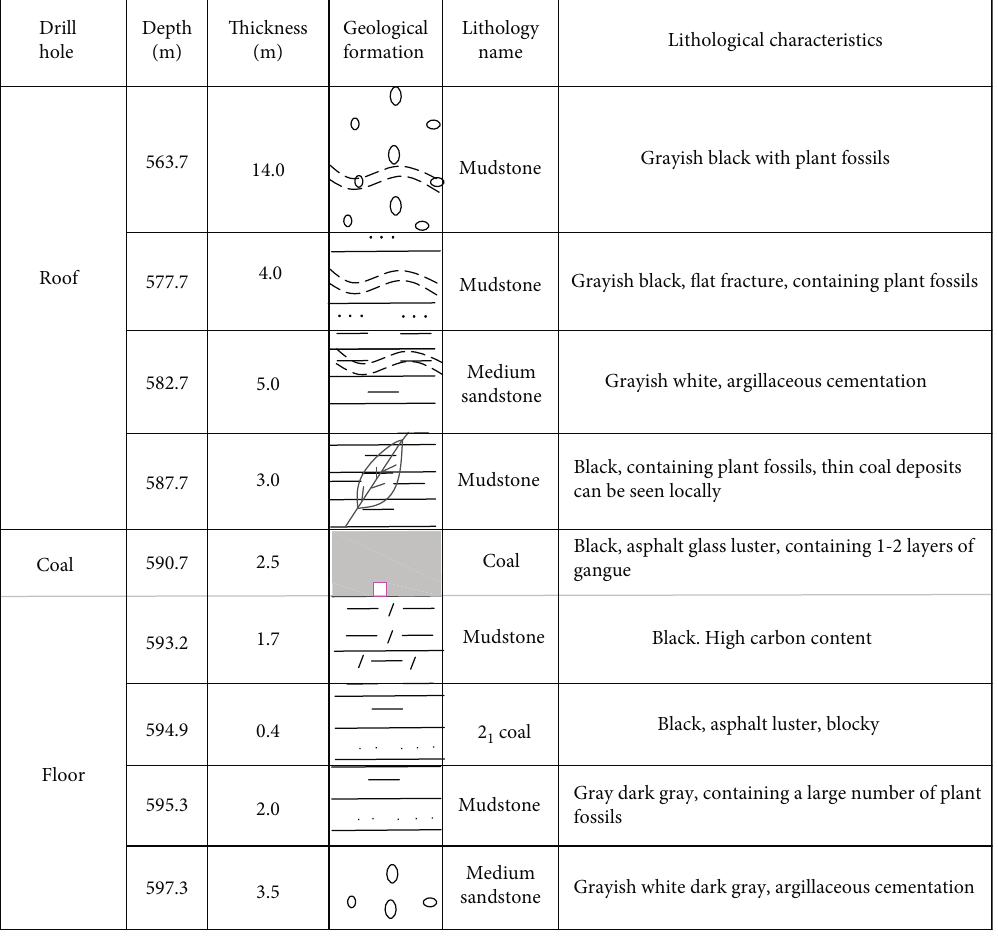
Figure 3: Geological